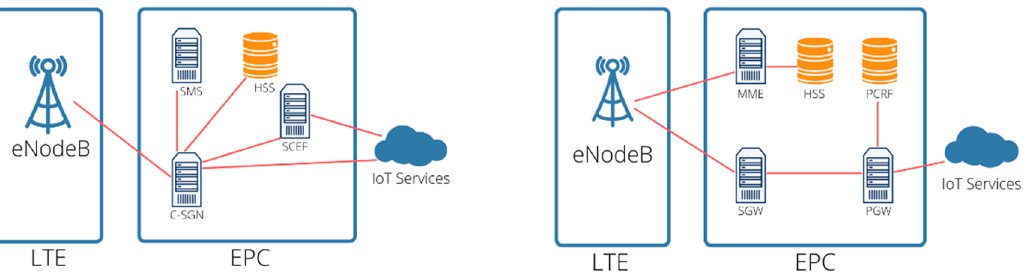
Figure 6. The architecture of NB-IoT. The communication of eNodeB with IoT services through EPC interfaces.